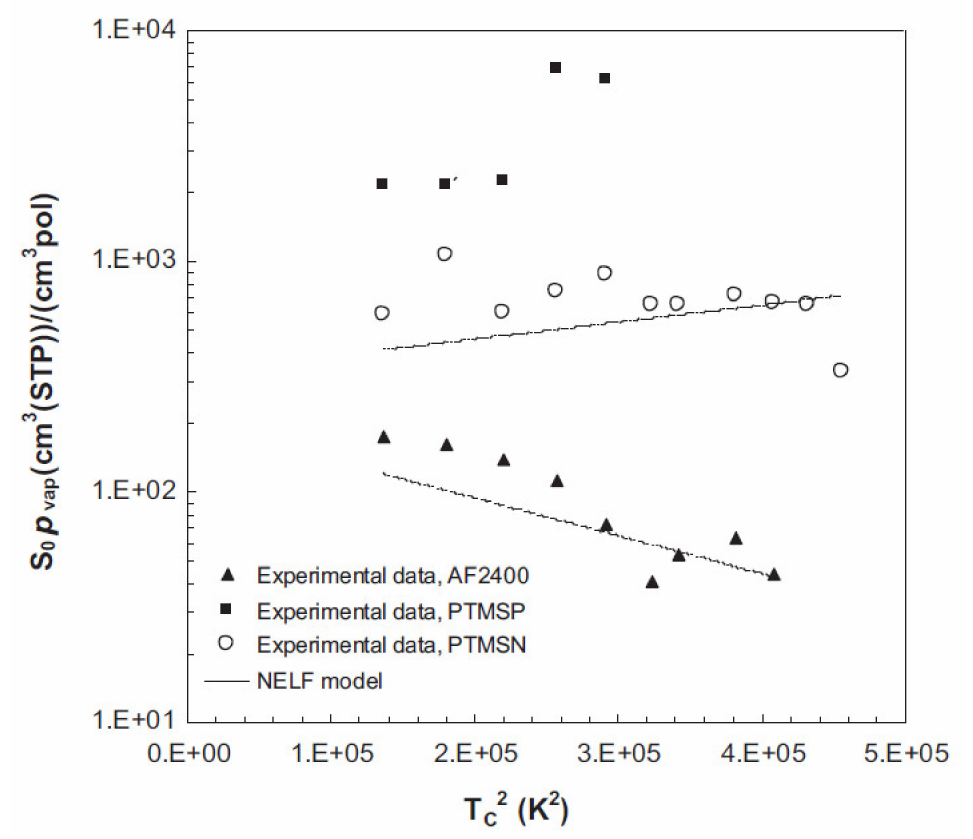
Figure 9. Activity-based solubility coefficients of n-alkanes at infinite dilution in poly(trimethyl silyl propyne)—PTMSN, poly(trimethyl silyl propyne)—PTMSP and Teflon AF2400 at 25–35 ◦ C and exponential interpolations of NELF model predictions on the same system with k12 = 0 for PTMSN, k12 = 0.04 and k12 = 0.87 for Teflon AF2400 (used with copyright permission)